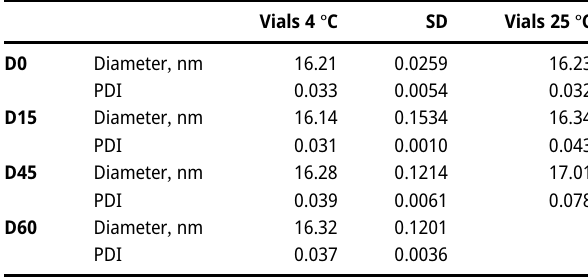
Table  : Hydrodynamicdiametersandpolydispersityindex(PDI)forvials Table  : Hydrodynamic diameters and polydispersity index (PDI) for containing  mg/mL and stored at  ° C (n=  ) and at  ° C (n=  ). bags following dilution to  .  mg/mL (C  ) and  .  mg/mL (C  ). Vials  ° C Mean C 